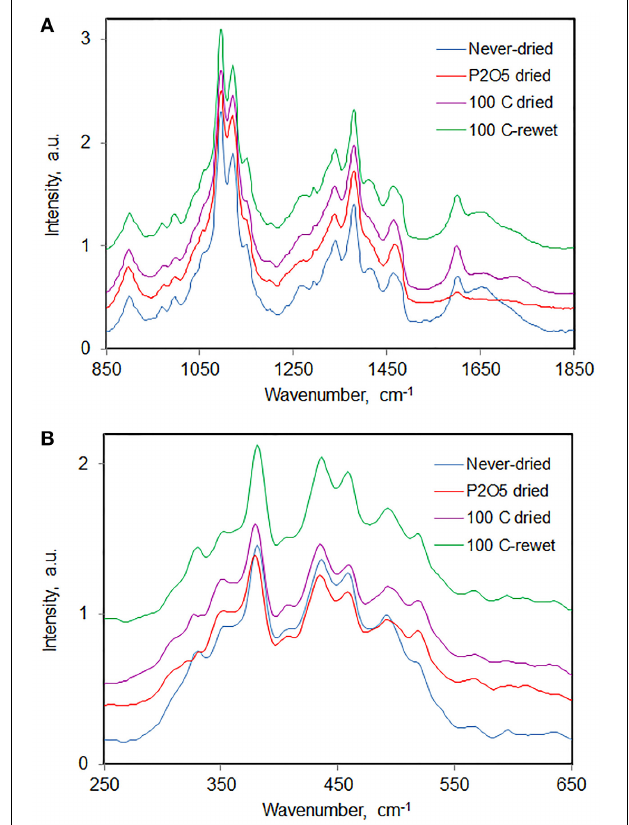
FIGURE 9 | Effect of water removal on 2890cm − 1 band intensity. (A) BNSWKP, (B) cellulose I, cellulose II, and amorphous cellulose. as a function of variation in moisture content are based on the phenomenon of “self-absorption” (Agarwal and Kawai, 2005).